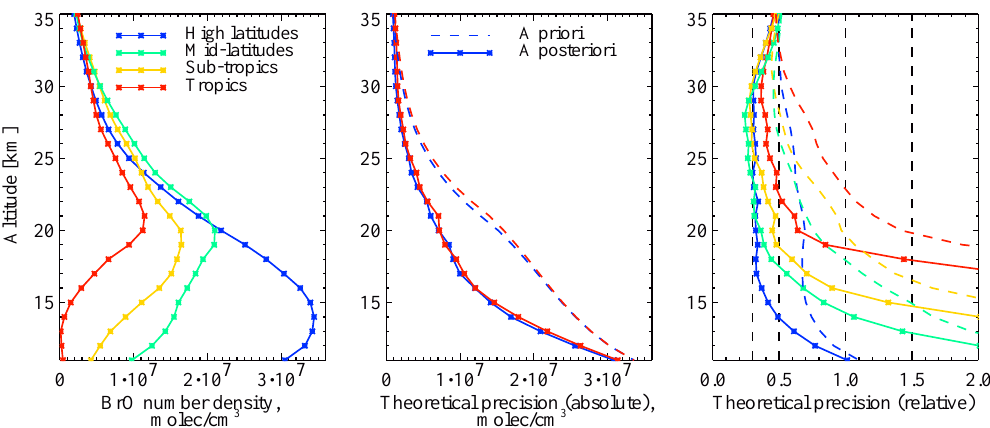
Fig. 5. Retrieved vertical profiles of BrO and theoretical precision of the retrieval typical for the IUP Bremen algorithm. Left panel: vertical profiles of BrO typical for high-latitude spring, mid-latitude fall, subtropical summer, and tropical winter seasons. Middle panel: theoretical precisions (solid lines) and a priori constraints (dashed lines) for high-latitude (blue) and tropical (red) retrievals. Right panel: same as in the middle panel but in relative units.